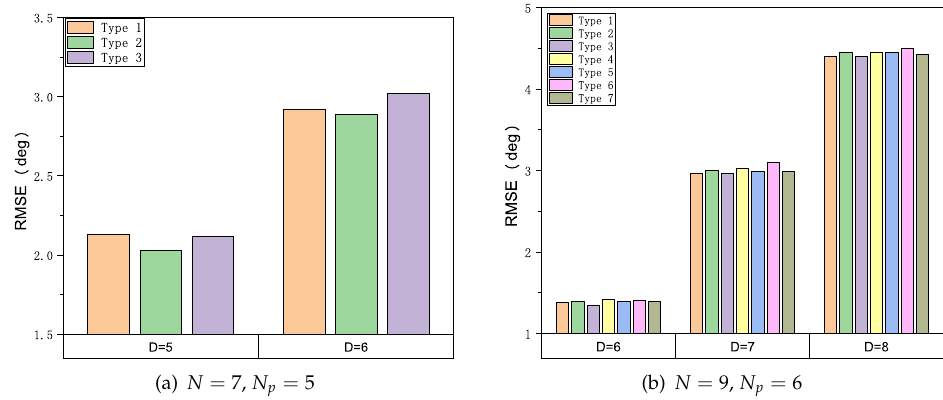
Figure 5. RMSE under Different Array Configurations; SNR = 15 dB, K =